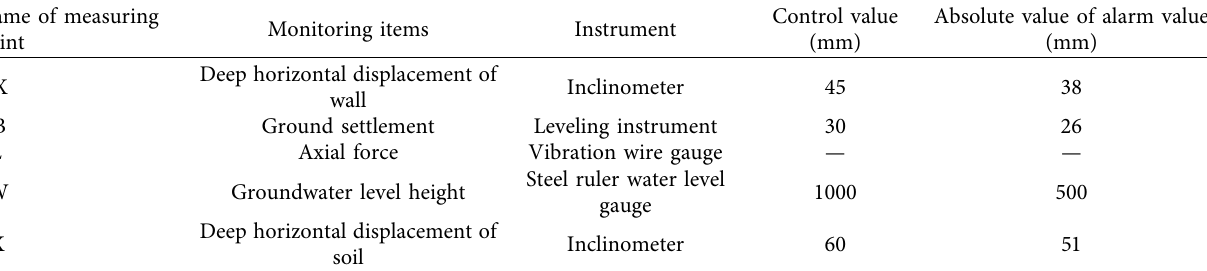
Table 2: Overall layout of the instruments installed